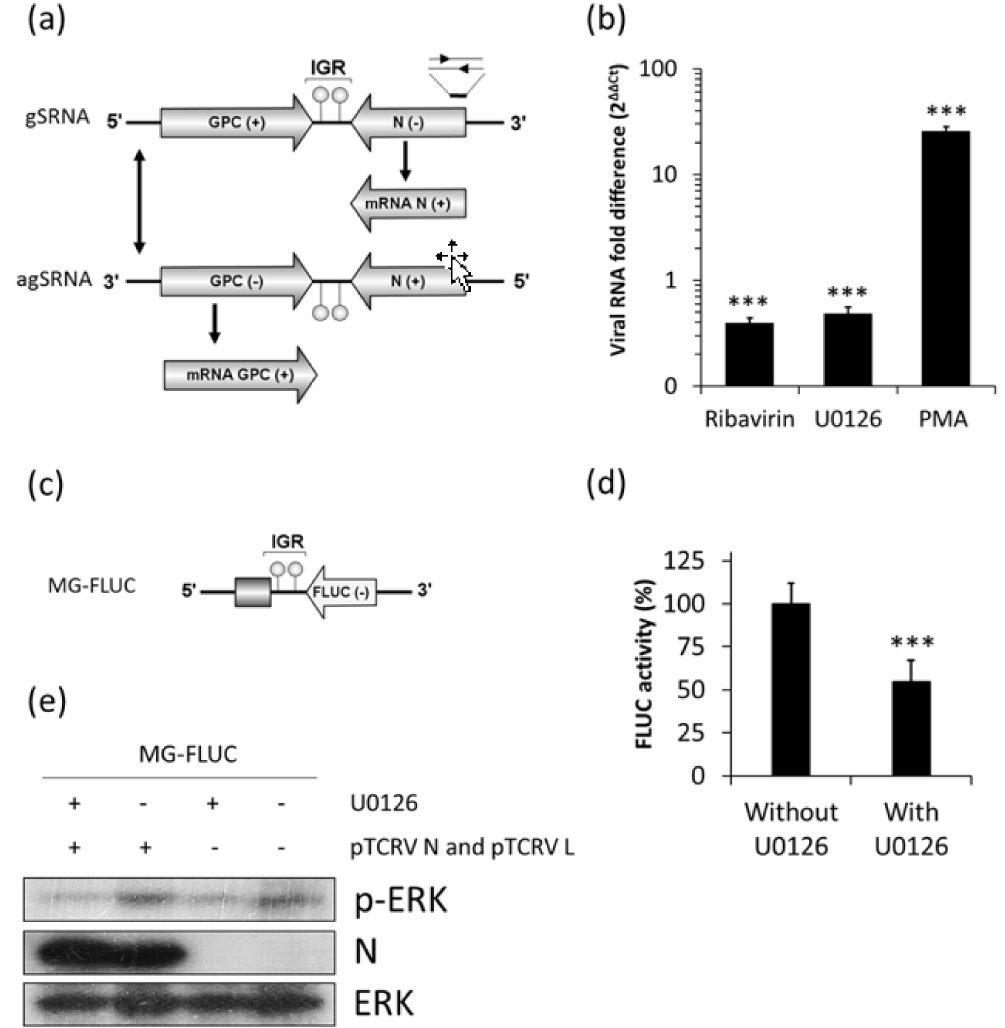
Figure 4. U0126 inhibits viral RNA synthesis. ( a ) Schematic representation of the S RNA transcription/replication processes. The genome S RNA (gSRNA) and the full-length antigenome S RNA (agSRNA), N mRNA, glycoprotein precursor (GPC) mRNA are depicted. IGR: intergenic region. The primers used for detection of gSRNA by Q RT-PCR are indicated with arrows; ( b ) Total RNA was extracted at 14 h p.i. from JUNV infected Vero cells treated with U0126 (15 µ M), ribavirin (100 µ M), PMA (100 nM), or left untreated, and gSRNA was detected by Q RT-PCR. Data represent mean values ± SD. ANOVA (Dunnett post-hoc test): *** p < 0.001; ( c ) Schematic representation of Tacaribe virus (TCRV) S RNA analog MG-FLUC (MG- firefly luciferase), which contains (5 (cid:48) to 3 (cid:48)